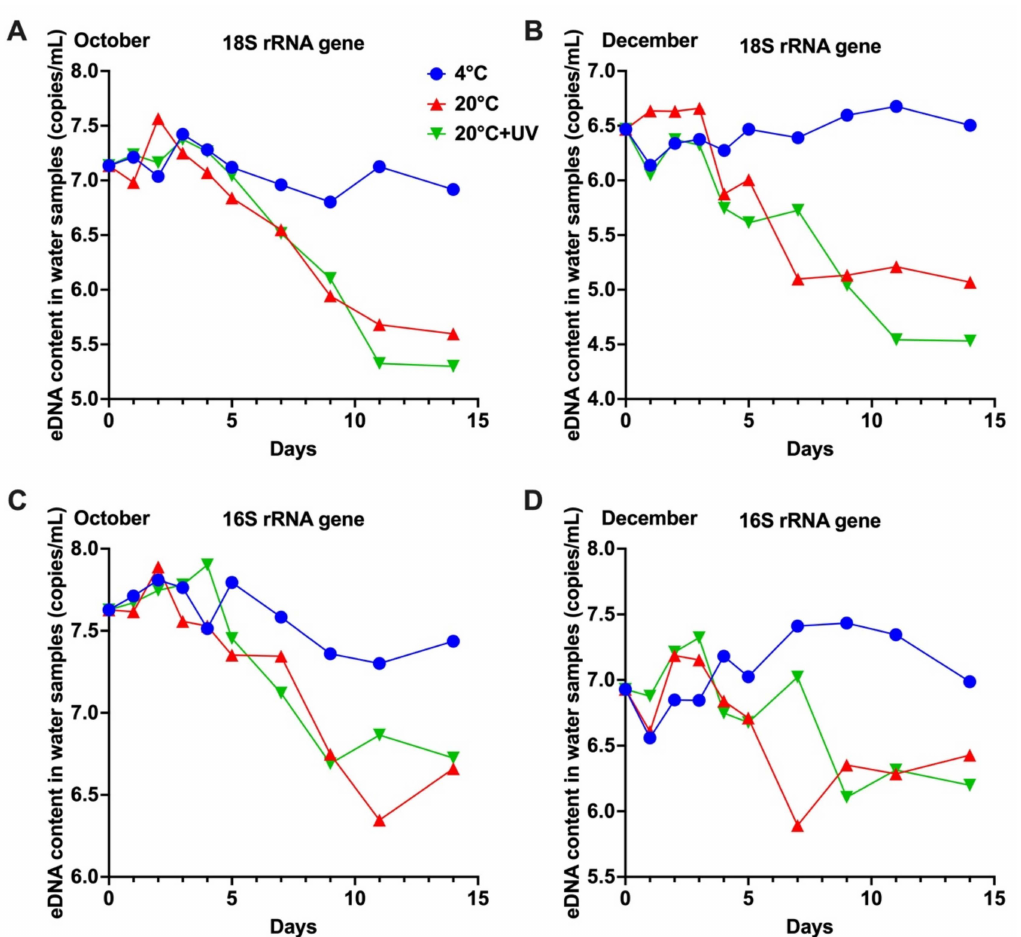
Figure 3. Residual eDNA content in the environment during the experiment period. ( A , B ) showed the concentration of 18S rRNA gene of eukaryotic DNA in the October and December samples, respectively. ( C , D ) showed the concentration of 16S rRNA gene of prokaryotic DNA in the October and December samples,